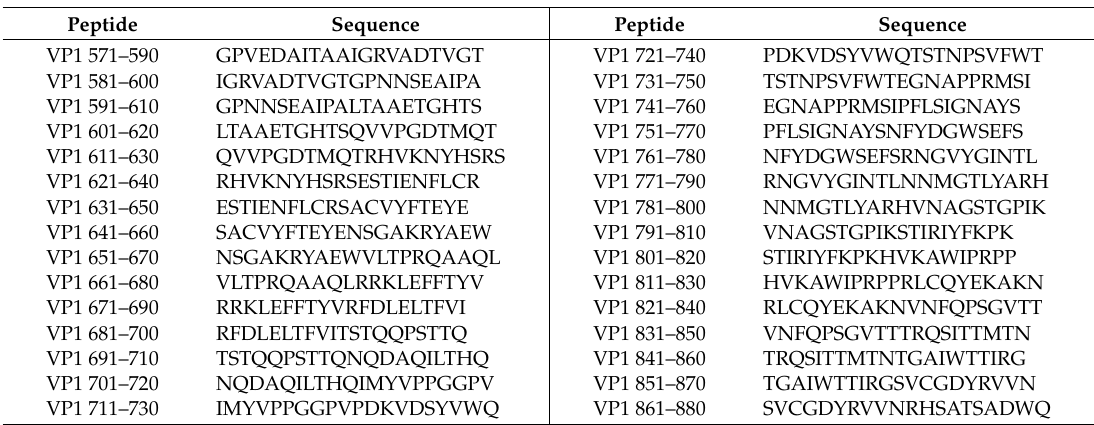
Table 1. List of CVB3 VP1 overlapping